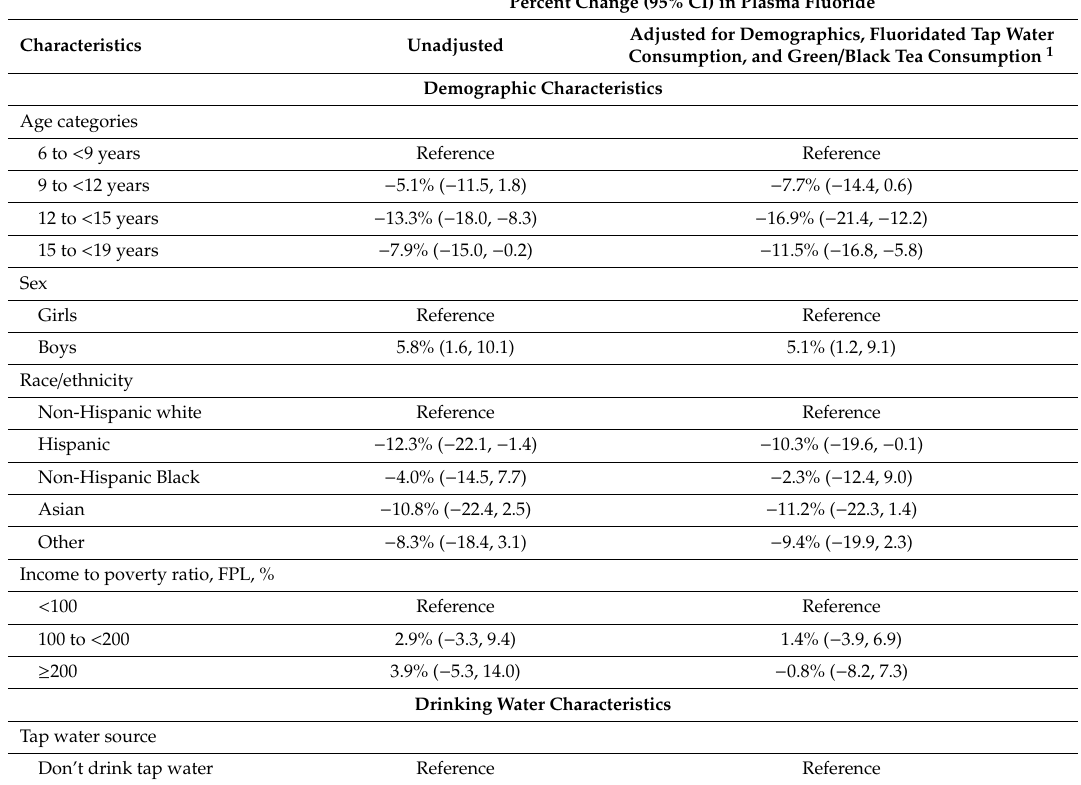
Table A1. Percent change in plasma fluoride by demographic characteristics and modifiable sources of fluoride consumption among 6–19-year-old National Health and Nutrition Examination Survey participants from